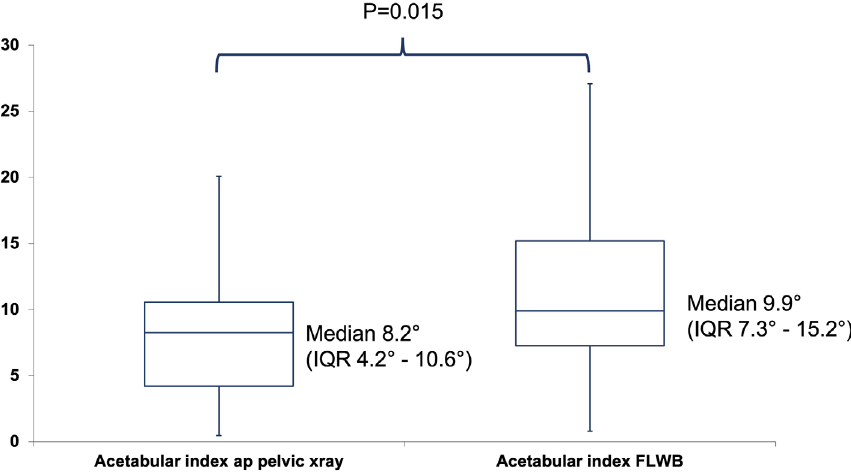
Figure 2. Box plot depicting the acetabular index measured on conventional ap pelvic radiographs and full-length weight-bearing radiographs.